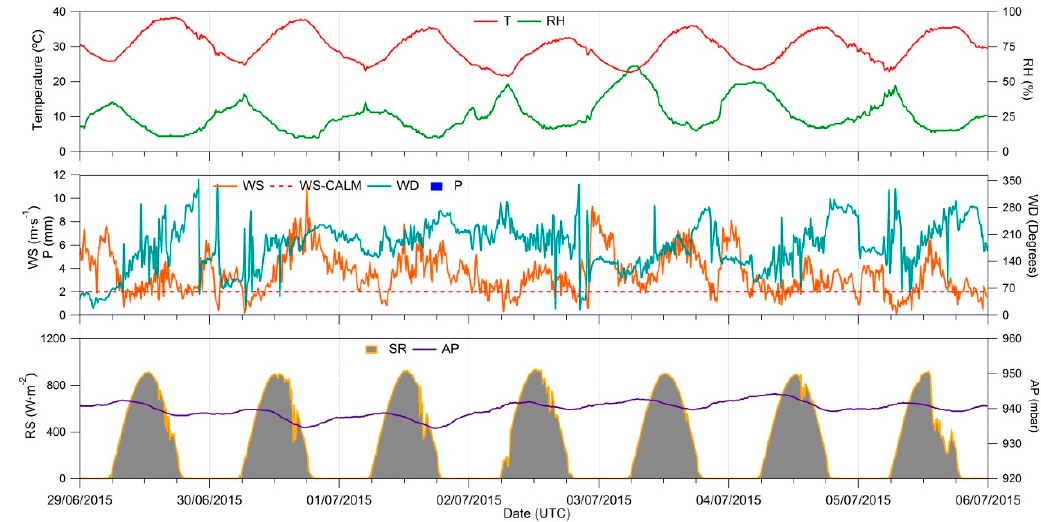
Figure 10. Meteorological parameter evolution during the week 29 June–5 July 2015. Temperature (T), Relative Humidity (RH), Wind Speed (WS) and Direction (WD), Solar Radiation (RS) and Pressure (AP) are shown.